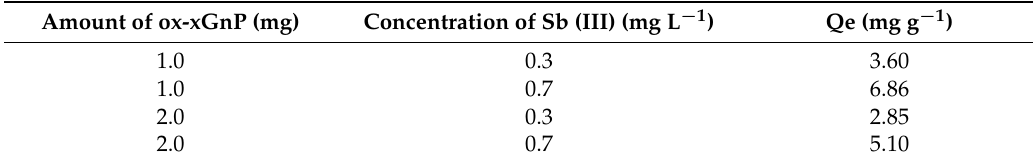
Table 1. Effect of sorbent amount on the sorption capacity.